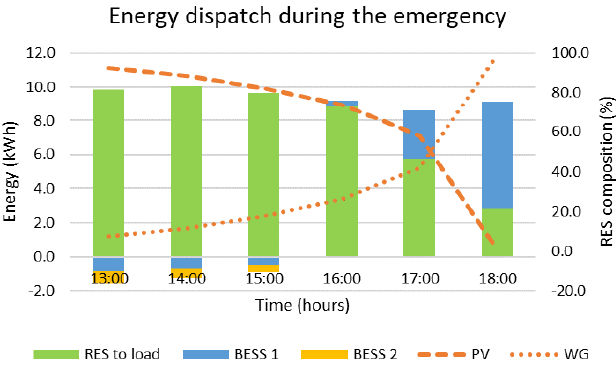
Figure 9. Energy dispatch for islanded operation from 13:00 to Figure 9 . Energy dispatch for islanded operation from 13:00 to 19:00.